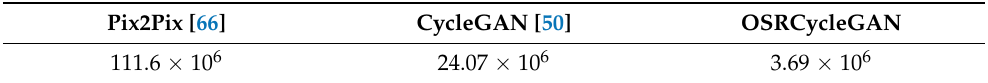
Table 14. Comparisons on #FLOPS of one image by Pix2Pix, original CycleGAN, and proposed OSRCycleGAN (unit: #FLOPS).